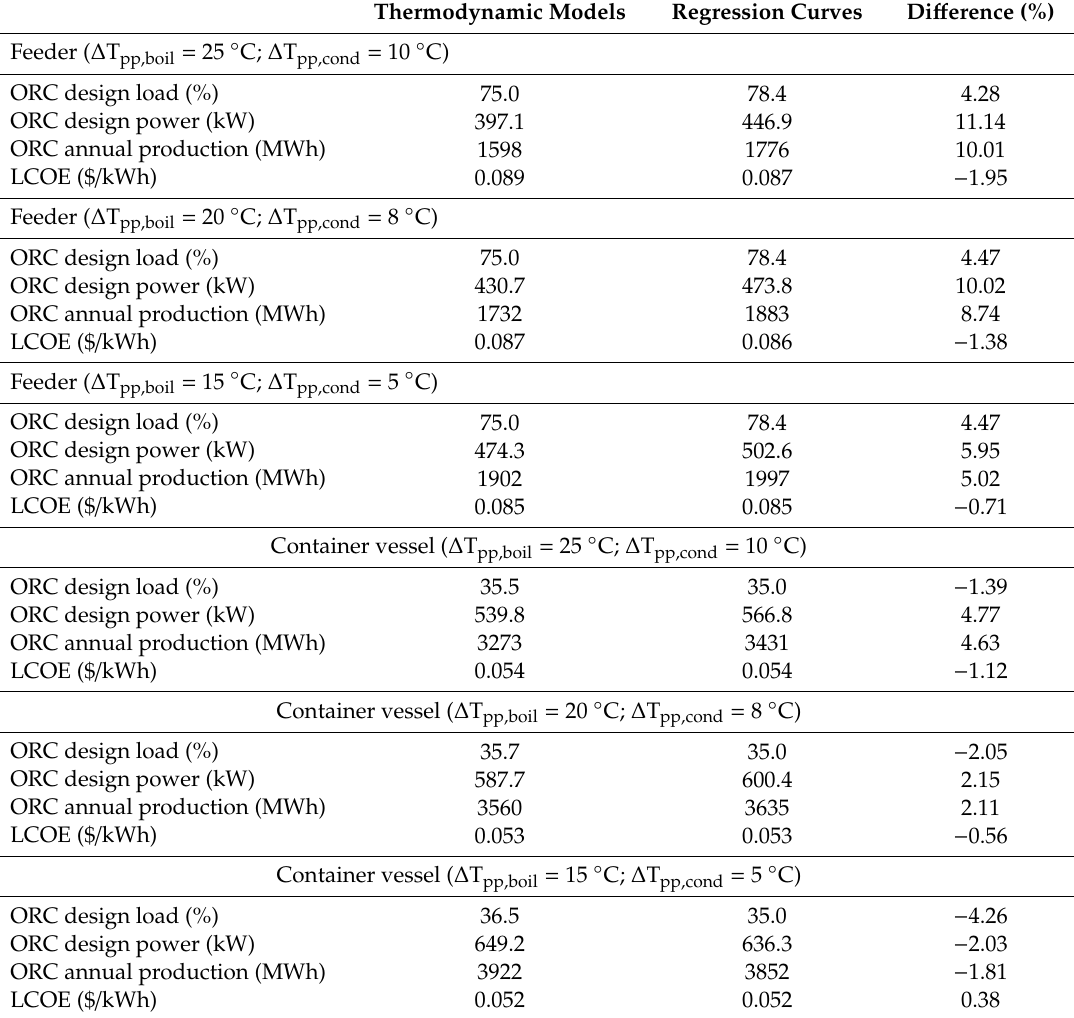
Table 9. Comparison between the solutions attained using the thermodynamic models and the regression curves (model #2): LCOE minimization